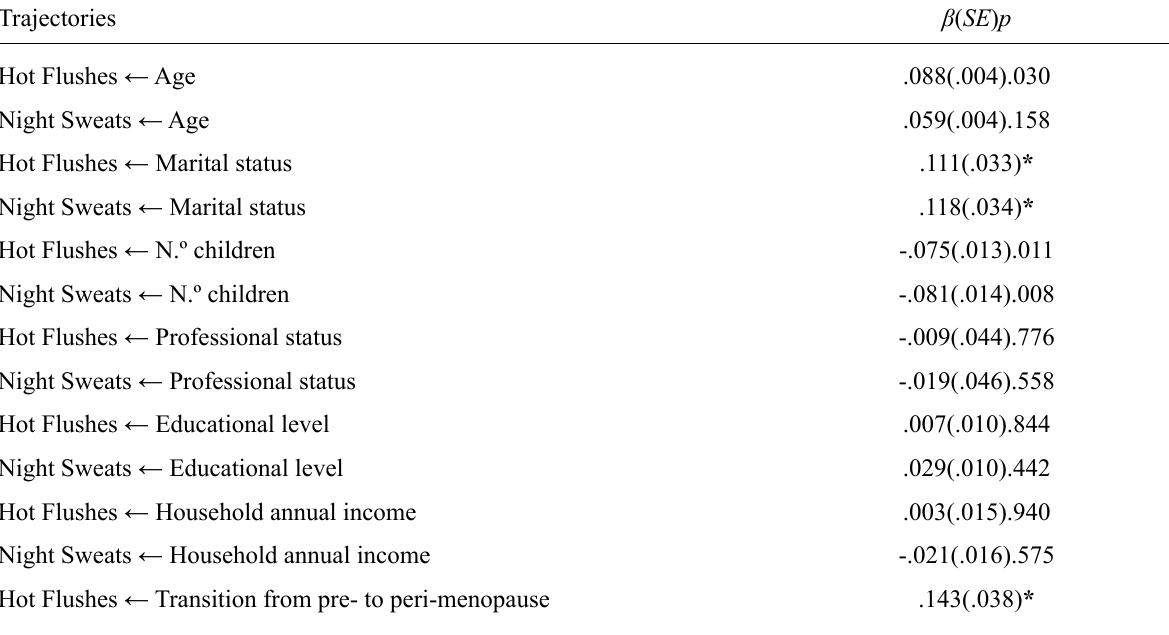
Structural Weights of Independent Variables (socio-demographics, health and menopause-related, lifestyle, stress and depressive mood) in Relation to the Dependent Variables (presence of vasomotor symptoms) Trajectories